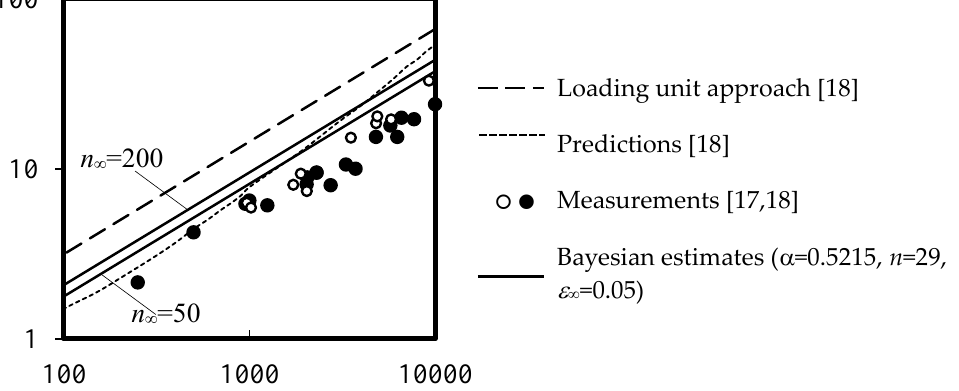
Figure 7. Design flow rates for some residential buildings in Japan. x -axis: loading unit U . y -axis: design and measurement flow rate q s (L · s − 1 ).